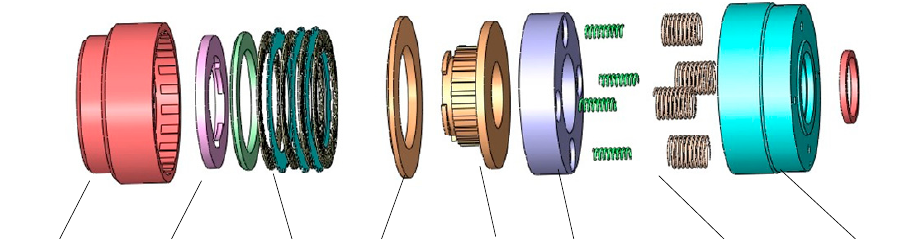
Figure 2. Three-dimensional model of a wet clutch